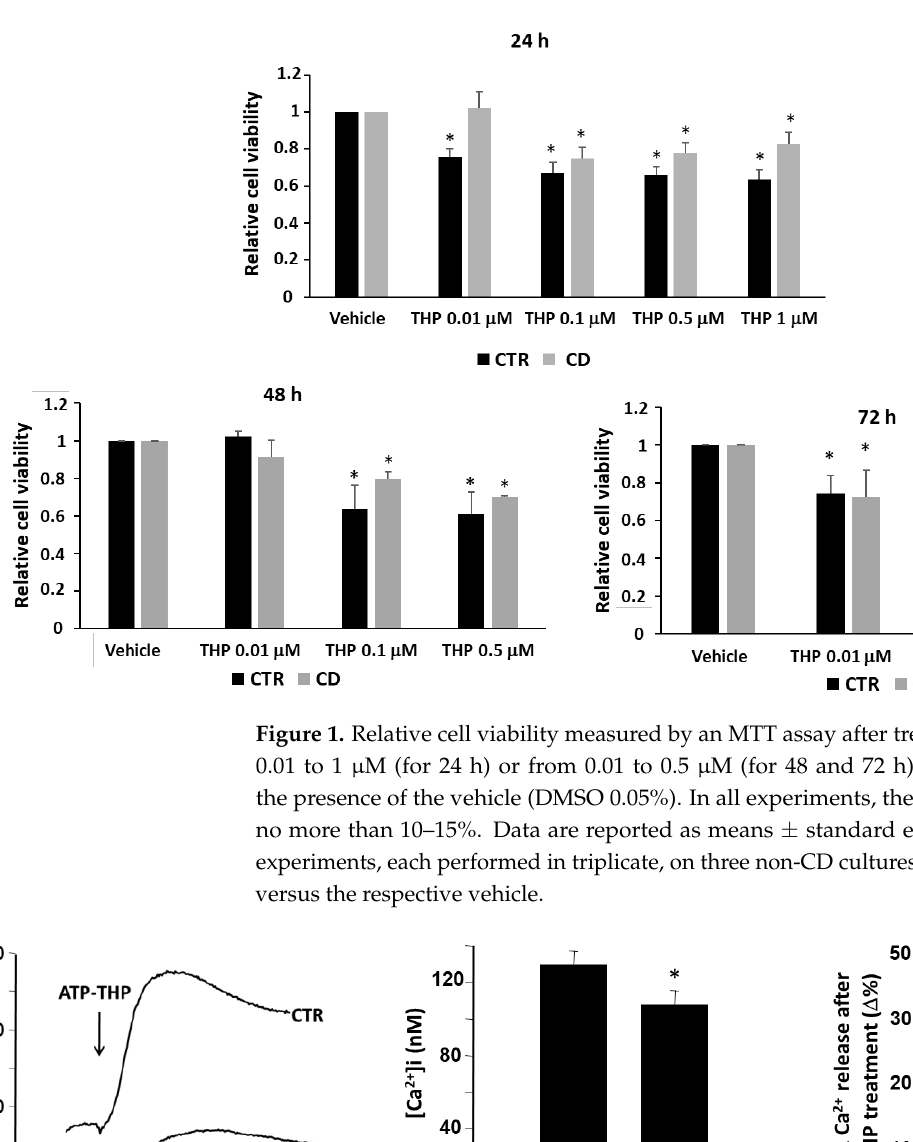
Figure 2. Ca 2+ level measurement in skin-derived fibroblasts. ( a ) Superimposed single-cell traces representative of the rapid effect of THP on [Ca 2+ ]i in one representative non-CD sample and one representative CD sample. Starting time of perfusion with THP is indicated by the arrow. ( b ) Quan- tification of basal [Ca 2+ ]i in four non-CD and three CD cultures. ( c ) Quantification of Ca 2+ release